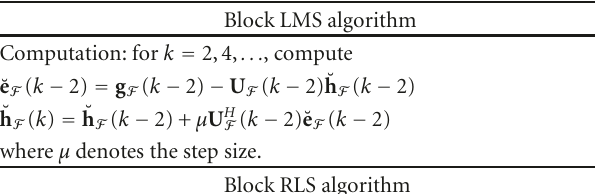
Table 3: Adaption algorithms for Alamouti-like transmissions. Block LMS algorithm